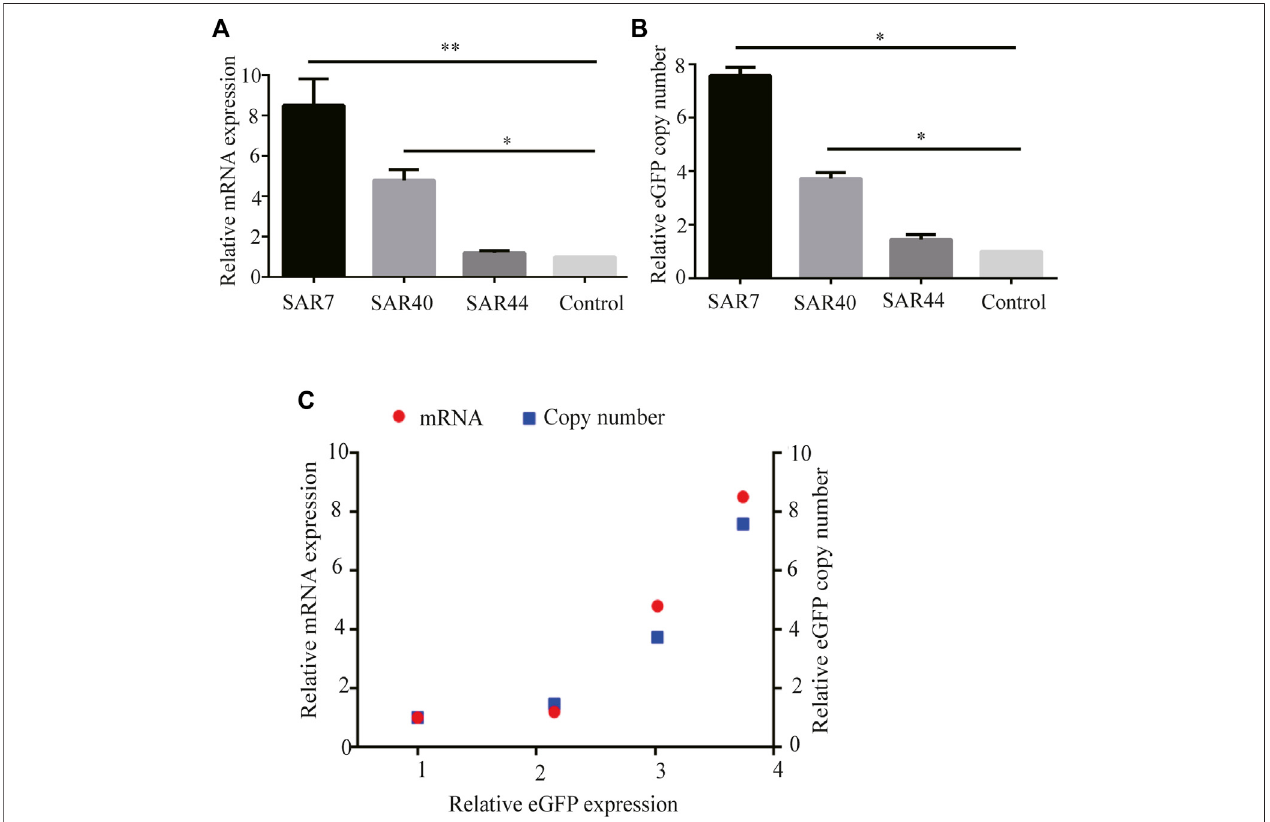
FIGURE4 | Analysis oftherelativeeGFP mRNAlevels and eGFP copy number in stably transfected CHO cells. Afterscreening underG418,the stable transfected CHO cellpoolswereacquired. (A) TotalRNAwasisolatedandcDNAsynthesiswasperformed,thenthemRNAlevelsweredetected usingqRT-PCR. (B) RelativeeGFP gene copy numbers were detected by qRT-PCR. (C) Correlation analysis between the relative eGFP copy (blue square), mRNA expression (red) and relative eGFP expression in long-term stable transfected CHO cells. Results were obtained from three independent experiments. The results are the mean values obtained for three independent experiments, and standard deviation is indicated (* p < 0.05; ** p <